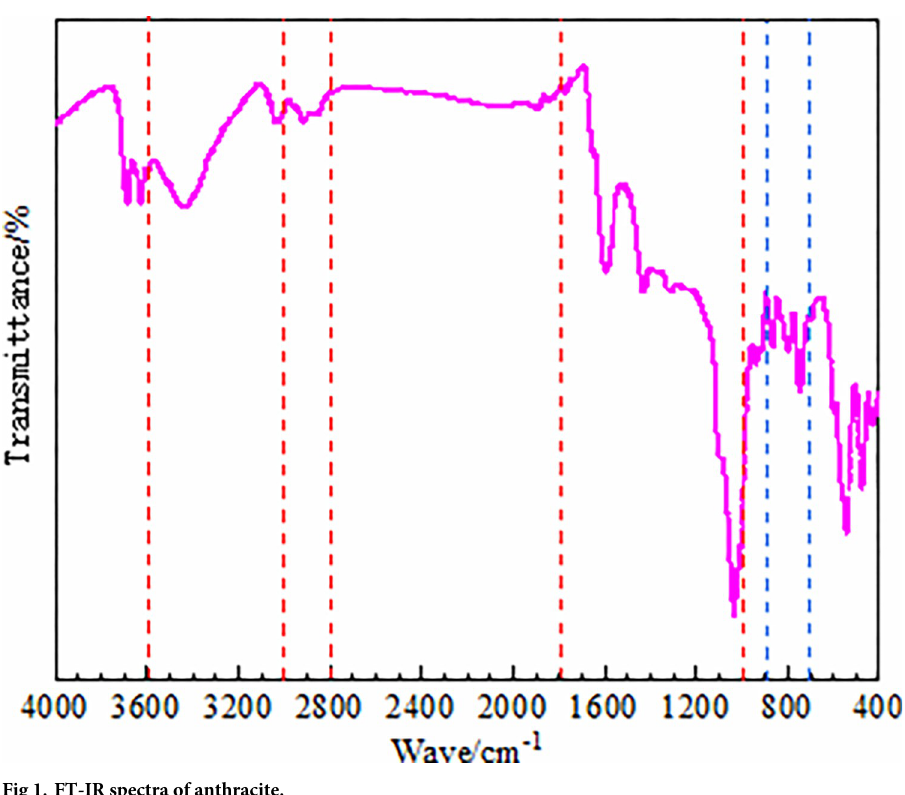
Fig 1. FT-IR spectra of